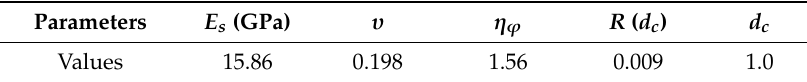
Table 4. Model’s parameters for